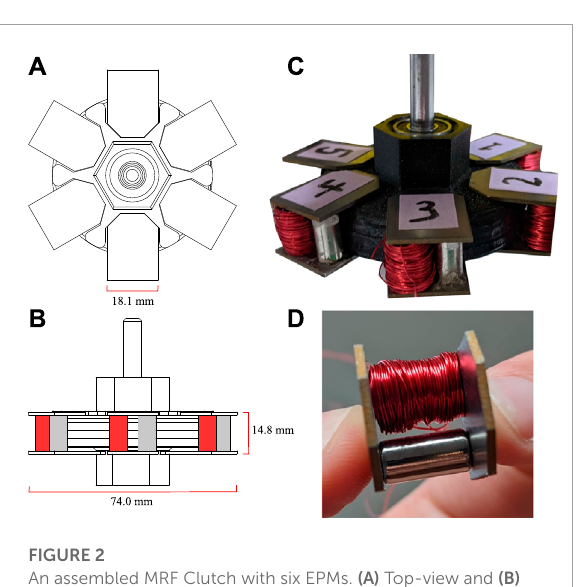
FIGURE 2 An assembled MRF Clutch with six EPMs. (A) Top-view and (B) Side-view. The coils are not depicted in the 3D rendering, but their locations are highlighted in red, while the NdFeB magnet is shown in gray. (C) A photo of the final MEC, shown from the isometric view (D) A single EPM, viewed head-on to see the two magnets and